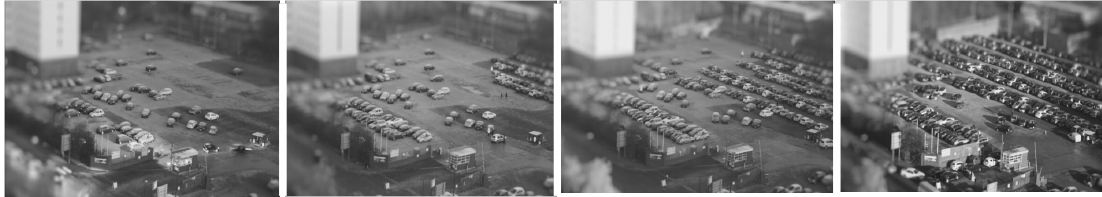
Figure 1. Photos of the progress of actual parking